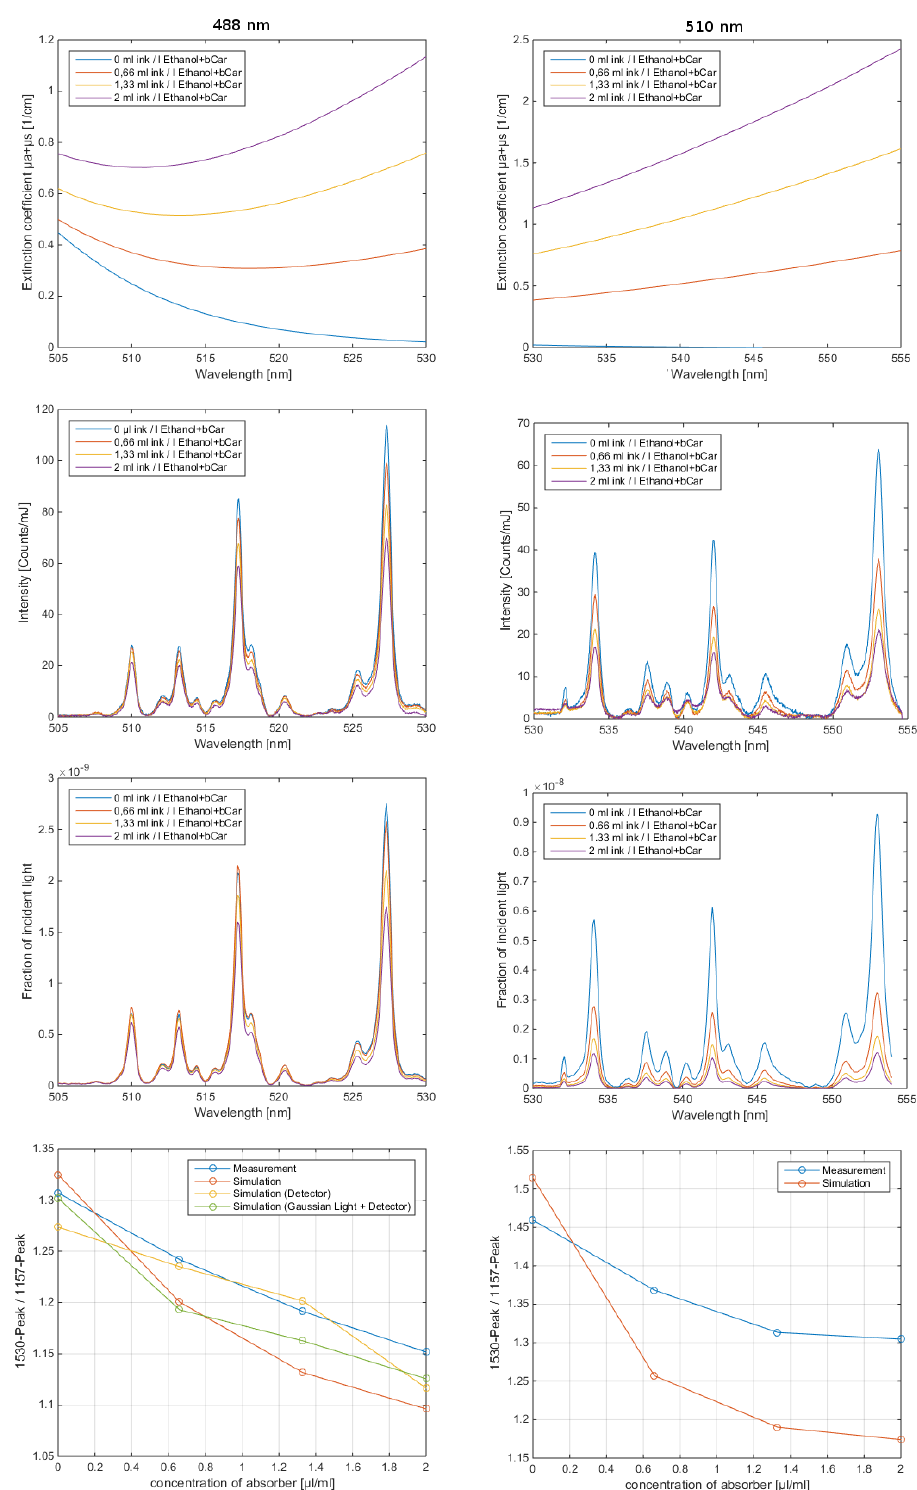
Figure 26. Correction of β -carotene Raman spectra for attenuation during propagation through an ink stained liquid sample at 488 nm ( left ) and 510 nm ( right ) excitation. The top row shows the absorption spectrum of the sample in the spectral range of the calculated β -carotene Raman spectrum. The second row shows experimental data to be compared to the calculated spectra in the third row. The bottom row shows the peak ratio of the two strongest β -carotene Raman peaks for experimental and simulated data. For 488 nm excitation, the effect of inclusion of a finite size detector and illumination by a Gaussian beam is shown as